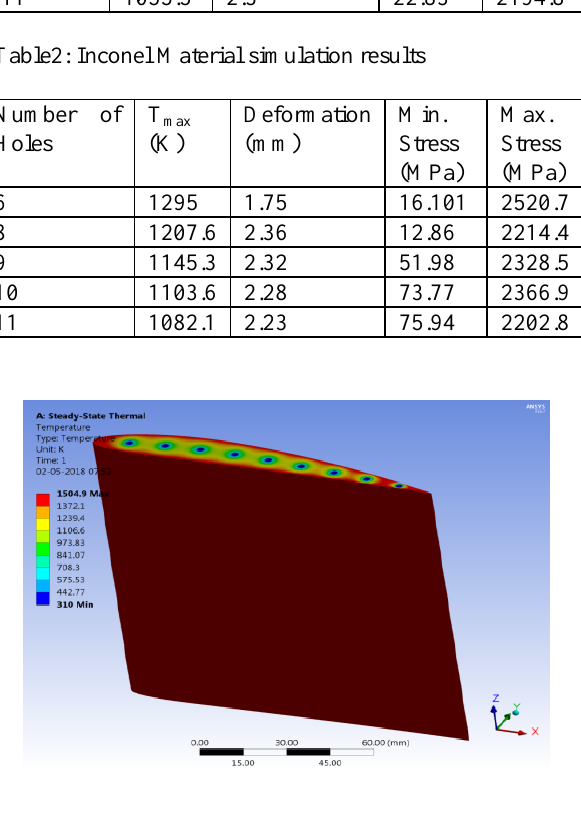
Figure 5 : Temperature distribution for nimonic with 9 holes The above figure describes the temperature distribution of nimonic material with 9 holes. Maximum temperature distribution is obtained at upper and lower surface of the blade. Minimum Temperature is noticed at camber line.